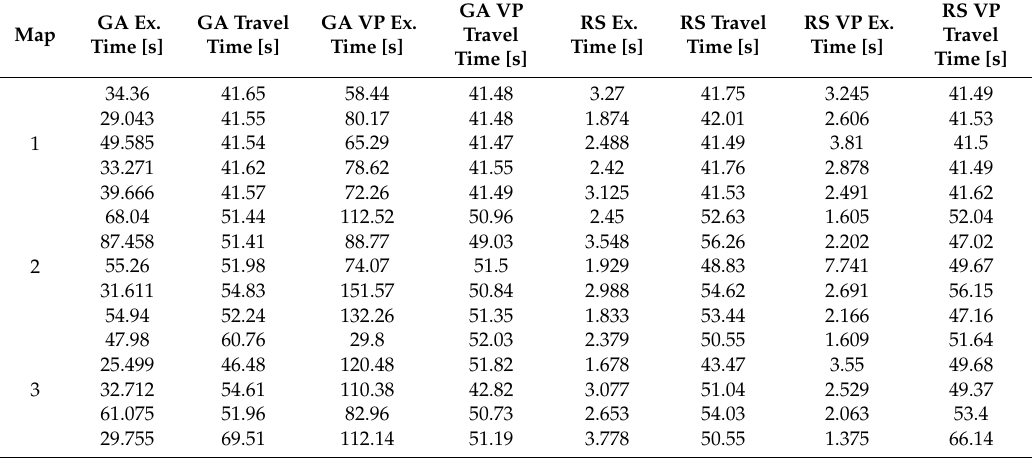
Table 3. Experiments results: times of execution and result times of the result paths.